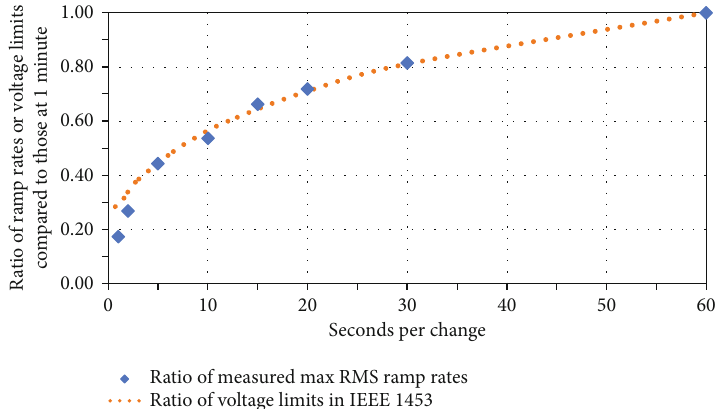
Figure 8: Ratio of the maximum RMS ramp rate calculated over all 10-minute windows for each irradiance sensor as compared to the maximum RMS ramp rate at one minute plotted against the ratio of voltage thresholds in IEEE 1453 for P at a resolution of one change per minute.